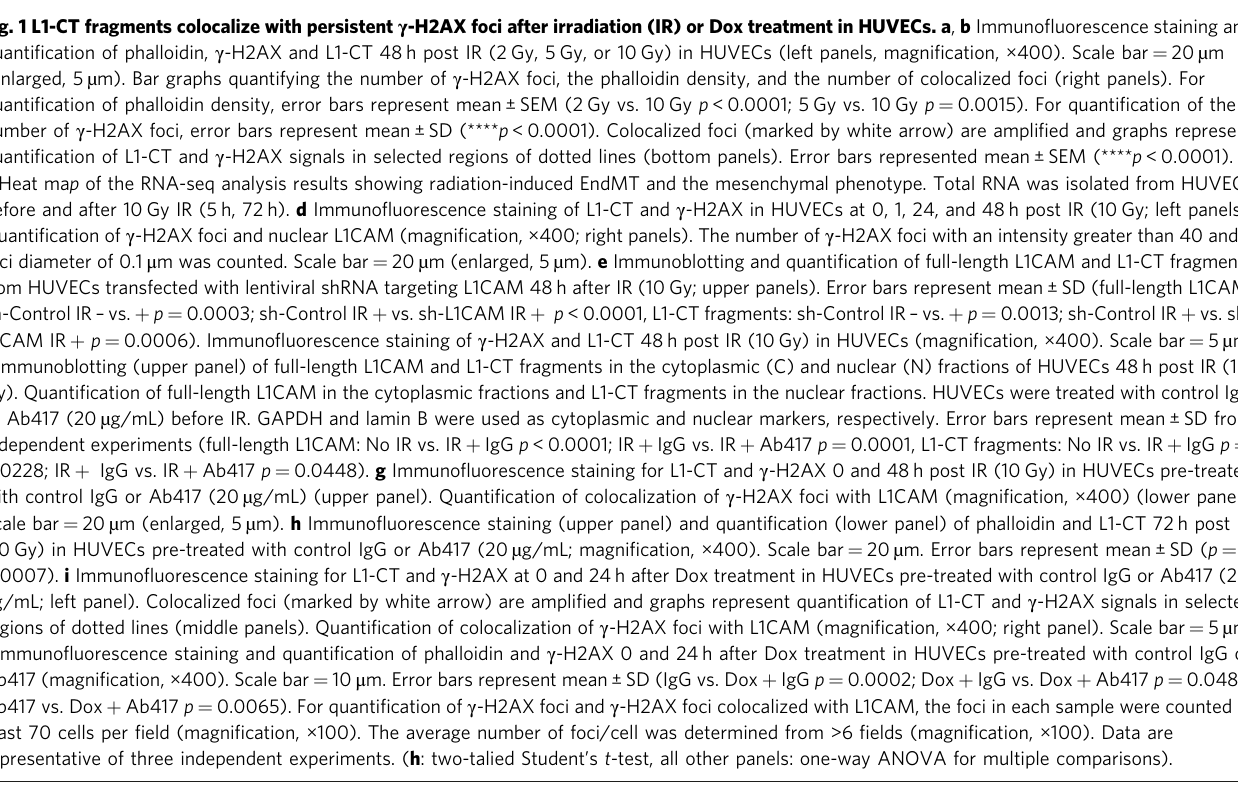
NATURE COMMUNICATIONS |